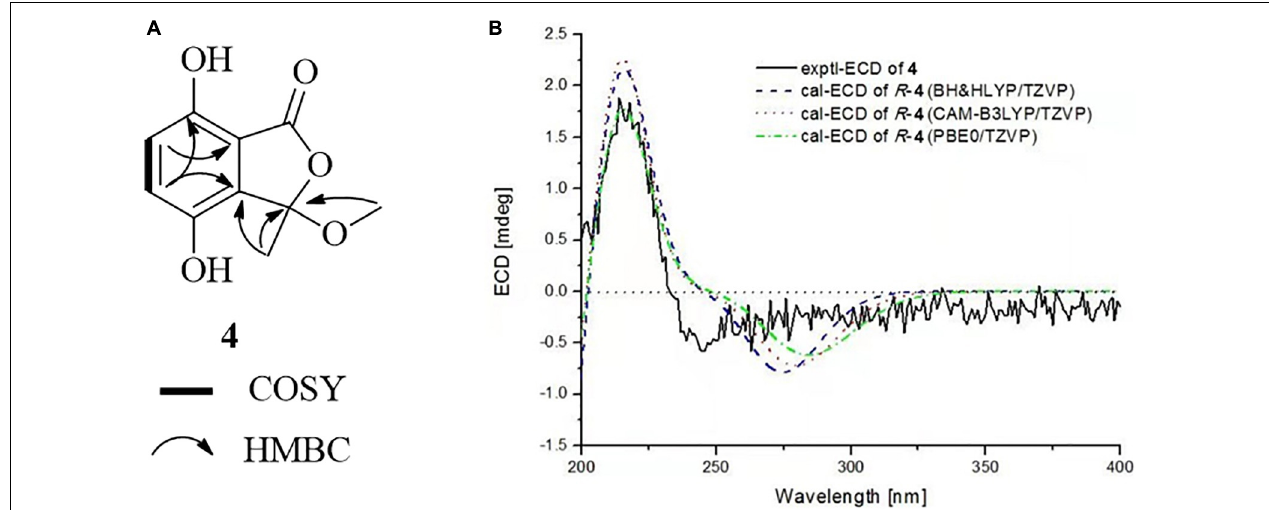
FIGURE 5 | (A) COSY and HMBC correlations of 4 . (B) Experimental and calculated ECD spectra of 4 in MeOH.